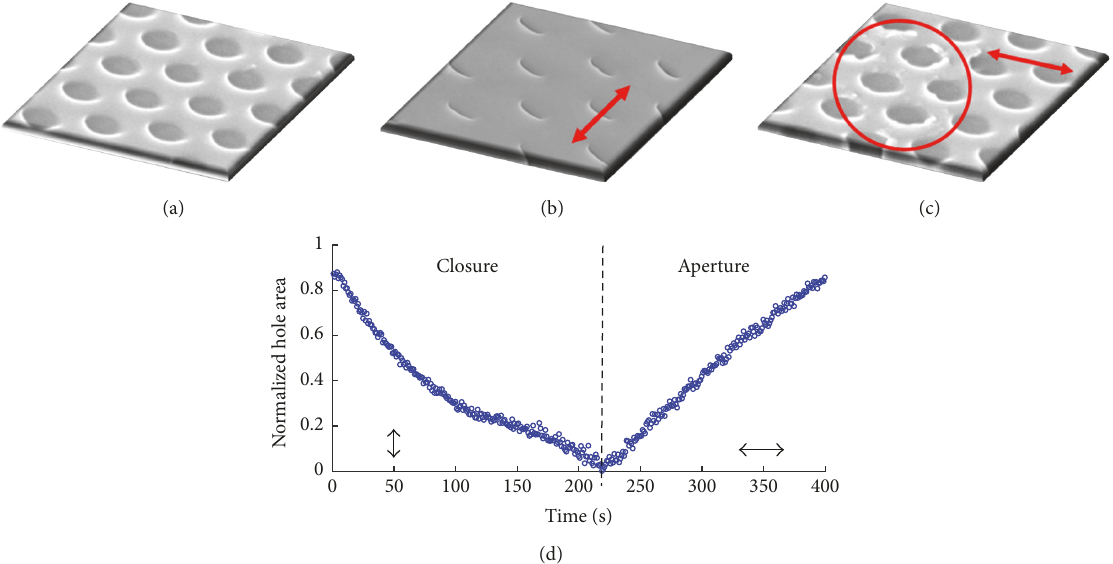
Figure 3: Photoreconfiguration of pristine microwells arrays by using linearly polarized light: (a) original concavity shape, (b) closed slits, and (c) restored shape. (d) Time-resolved hole area values for pores during laser irradiation with time-varying polarization states.